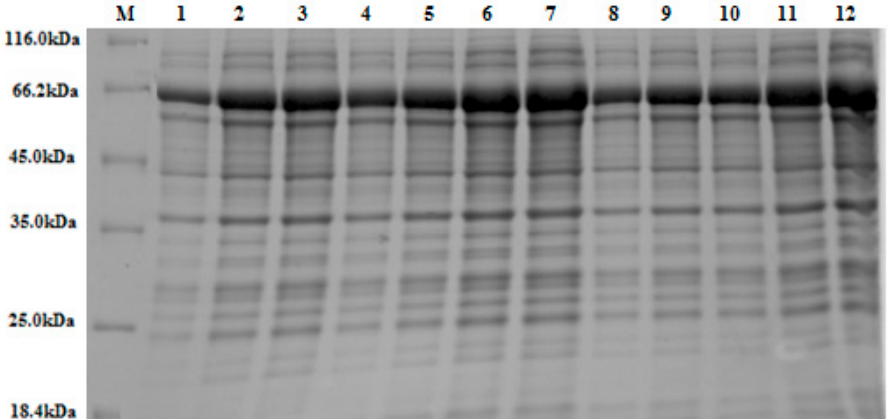
Figure 4. A 10% (w/v) SDS-PAGE stained with Coomassie Brilliant Blue. The figure depicts various band sizes of crude β -glucosidase expressed in accordance with the 12 experimental runs, according to Plackett-Burman Design (see Section 2.2.4). An equal volume of crude extract (15 µL) was loaded into each lane. Lanes 2, 3, 6, 10, 11, and 12 display larger over-expressed protein bands at the expected molecular weight for the recombinant β -glucosidase/GST fusion protein (~65 kDa), as based on ImageJ densitometric analysis. This result mirrors the increased enzyme activity (U/mL) observed in these experimental runs (see Table 2). Note: M = protein marker (14.4–116 kDa).